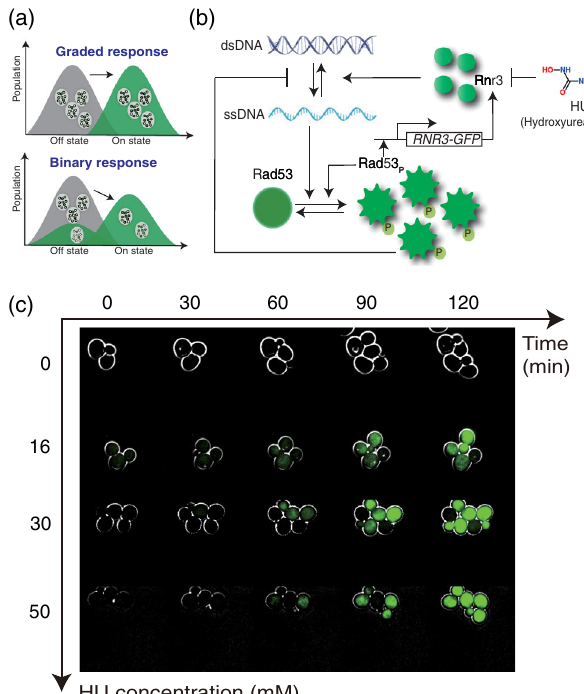
FIG. 1. Role of noise in the activation process of cell signal transduction pathways and the single-cell level experiment of hydroxyurea-induced S-phase checkpoint activation in budding yeast. (a) Two typical mechanisms of the activation process in cell signal transduction pathways involving stochastic noise. The activation process of a population of cells may be realized by the graded response whereby the key kinase level in all cells increases, together with a single peak, or the binary response wherebyonlyaportionofcellsundergotheswitchliketransitionsof states with a bimodal distribution over time. (b) Schematic regu- latorynetworkthatgovernstheactivationoftheS-phasecheckpoint triggeredbyHUstressinbuddingyeast.AfterDNAdamageoccurs, upstream signaling promotes phosphorylation of Rad53, a key kinase in the S-phase checkpoint, as well as its autophosphoryla- tion. Phosphorylated Rad53 molecules activate the downstream kinase Dun1 and then significantly enhance the transcription of Rnr3, whichismarkedwith greenfluorescenceprotein (GFP) inthe single-cell experiment. This design allows us to determine the activation level of Rad53 by the fluorescence intensity of GFP. (c) Time-lapse fluorescence images of budding yeast WT strain cells in response to different doses of HU (0, 16, 30, and 50 mM). Time from exposure of yeast cells to HU treatment was